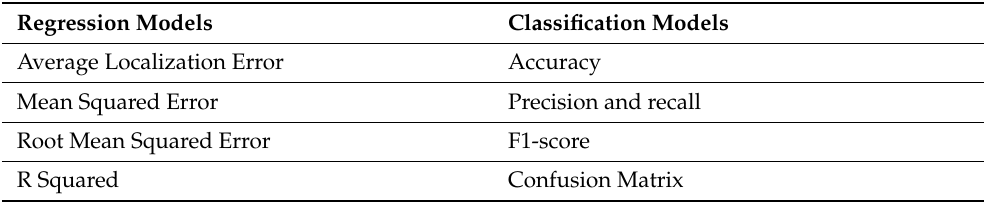
Table 3. Performance Evaluation of Machine Learning